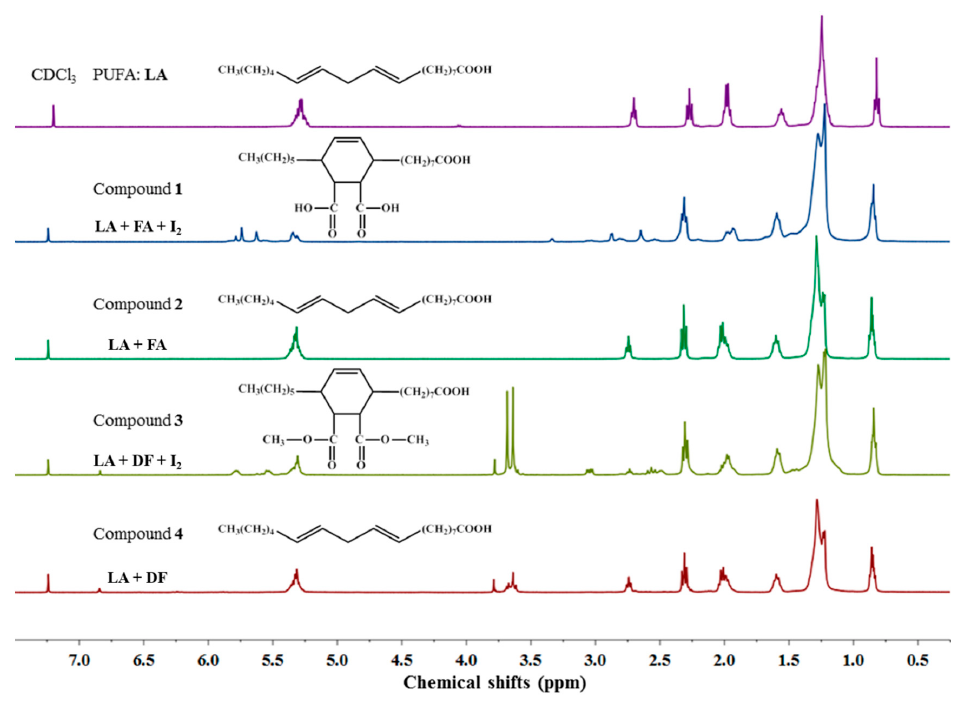
Figure 1. 1 H-NMR spectra of linoleic acid (LA) and reaction compounds with dienophiles in chloroform-d under di ff erent catalyst conditions: compound 1 , reaction product of LA and fumaric acid (FA) with iodine catalysis; compound 2 , reaction product of LA and FA without iodine catalysis; compound 3 , reaction product of LA and dimethyl fumarate (DF) with iodine catalysis; compound 4 , reaction product of LA and DF without iodine